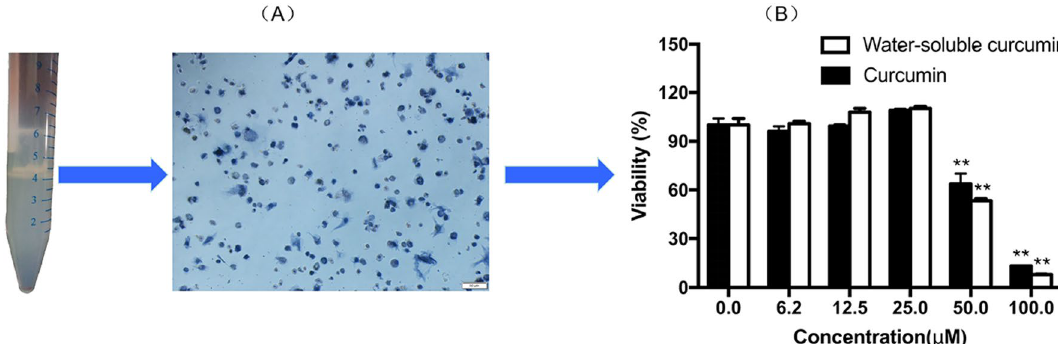
Figure 1. ( A ) 3β-HSD staining of purified rat Leydig cells (located in 4 mL scale). The positive cells were stained in dark blue color. ( B ) The viability of Leydig cells after curcumin or β-cyclodextrin–curcumin